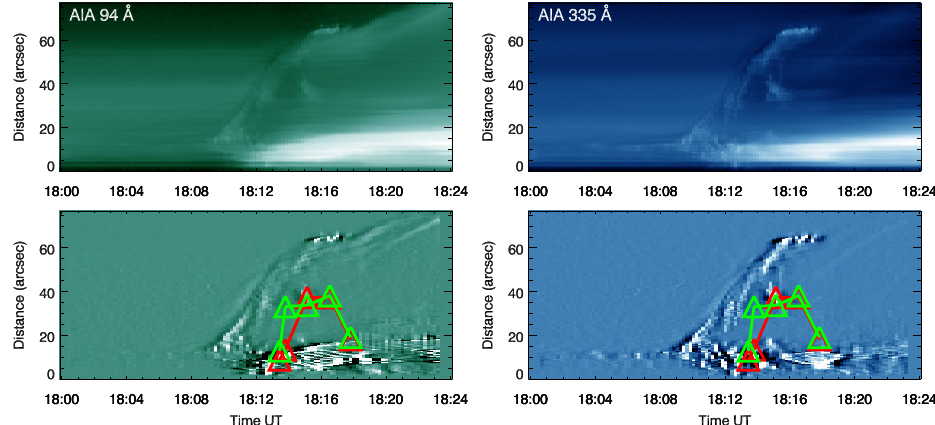
Figure 9. Top panels: time-distance diagrams of the S3 marked in Figure 3i at AIA 94 ˚A ( left ) and AIA 335 ˚A ( right ). Bottom panels: the smooth-subtracted images of top panels. Red triangles represent the movement trajectories of 6–12 keV X-ray sources, while green are 12–25 keV.